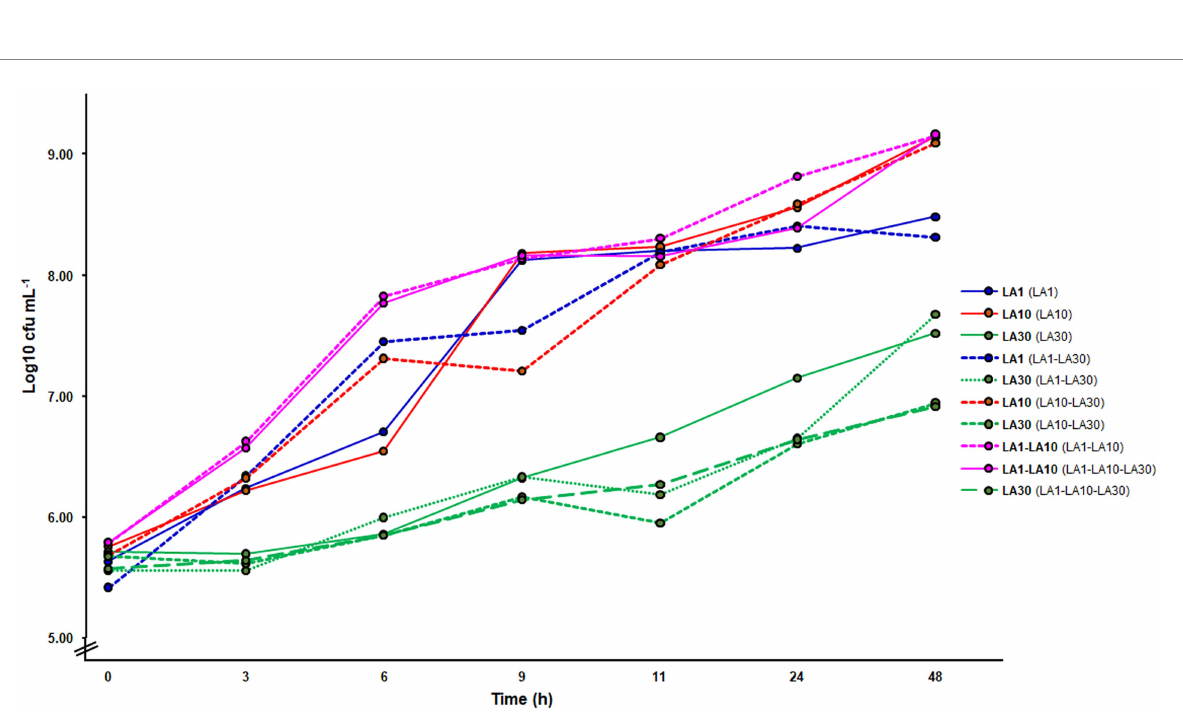
FIGURE 2 Microbial counts in GM17 (lactococci) and MRS ( Lactiplantibacillus plantarum ) along the fermentation of milk with the individual strains and their mixtures. In bold, the strain(s) counted on each of the curves; in parenthesis, the fermentation from which the counting was